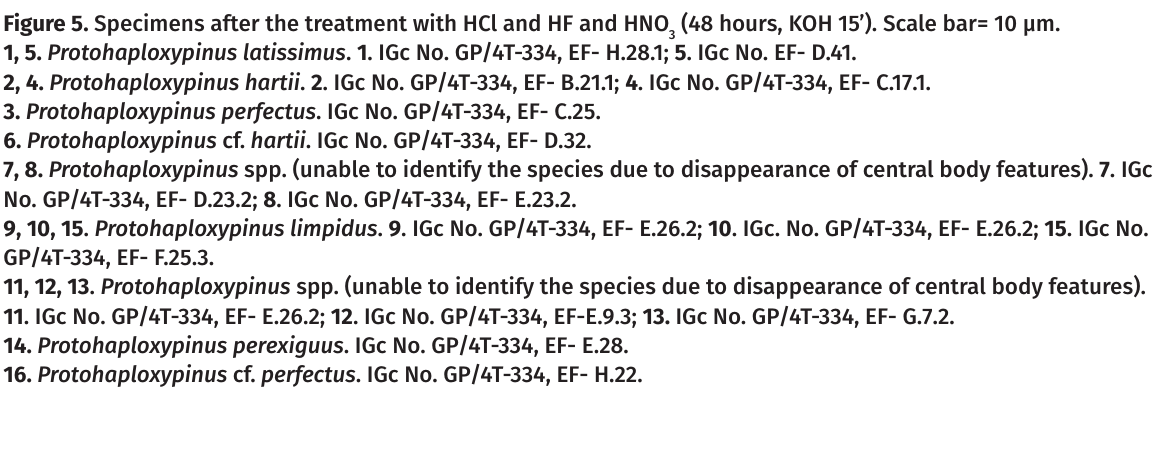
Figure 5. Specimens after the treatment with HCl and HF and HNO